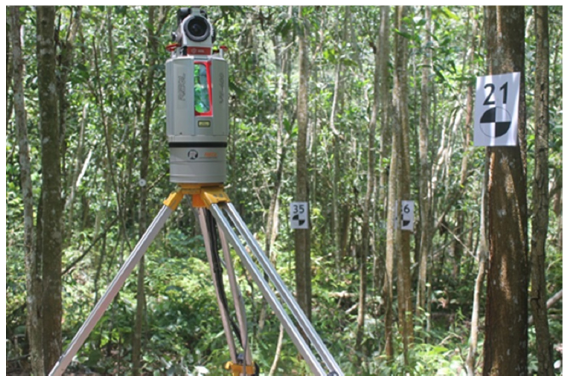
Figure 4. Individual tree measurement in a sample plot.